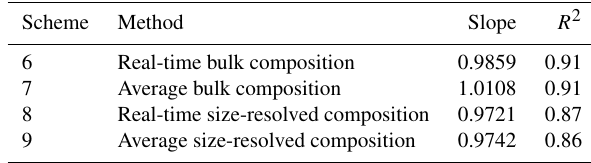
Table 4. The overview of different schemes used in the N CCN pre- diction based on HTDMA measurements.